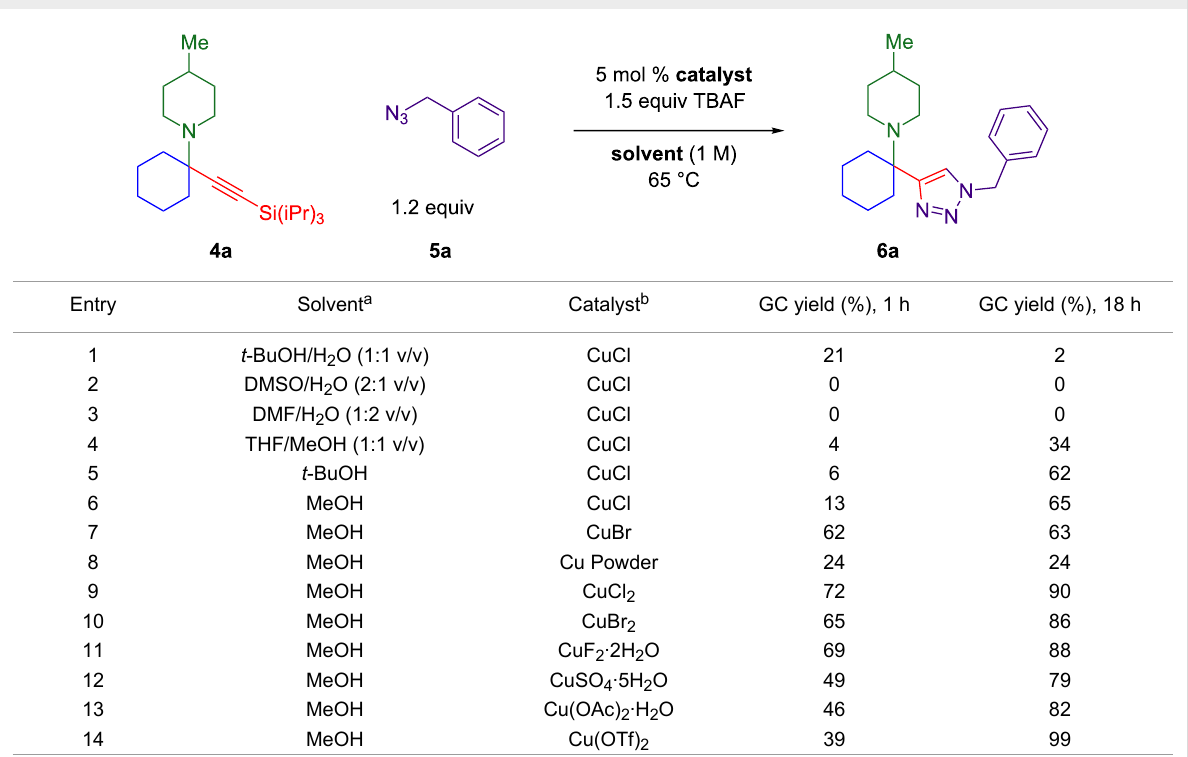
Table 1: Optimization of silyl